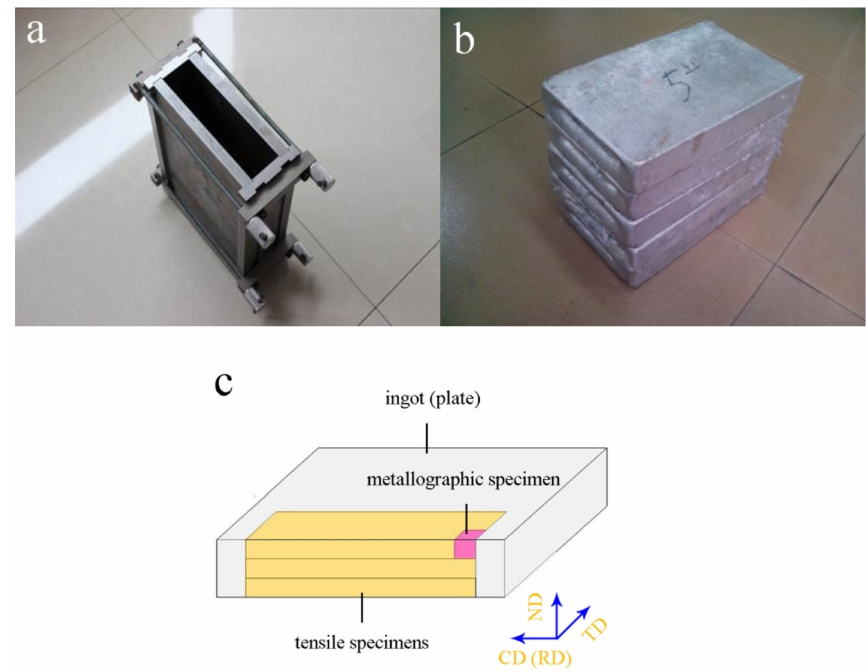
Figure 1. Ingot and sampling method: ( a ) metal model assembled by mechanical connection; ( b ) ingots cast at 700–720 ◦ C and ( c ) sampling method, mainly wire